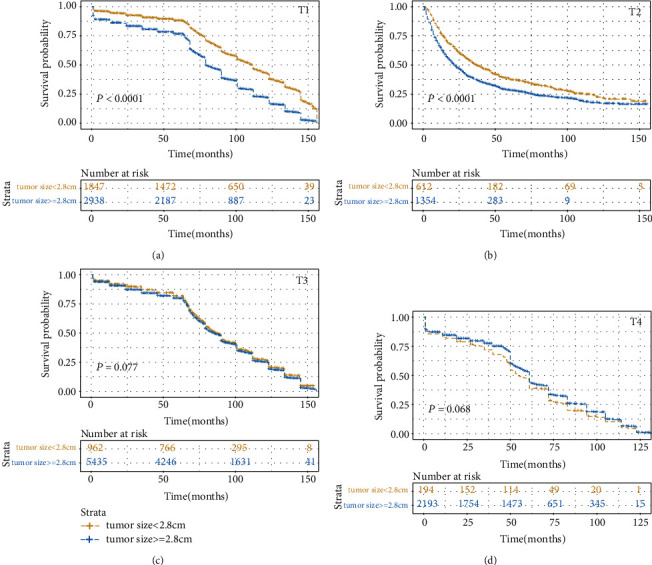
Kaplan-Meier survival curves compared tumor size less than 2.8 cm with tumor greater than or equal to 2.8 cm based on different T stages in the OS set: (a) in the T1 stage, (b) in the T2 stage, (c) in the T3 stage, and (d) in the T4 stage.